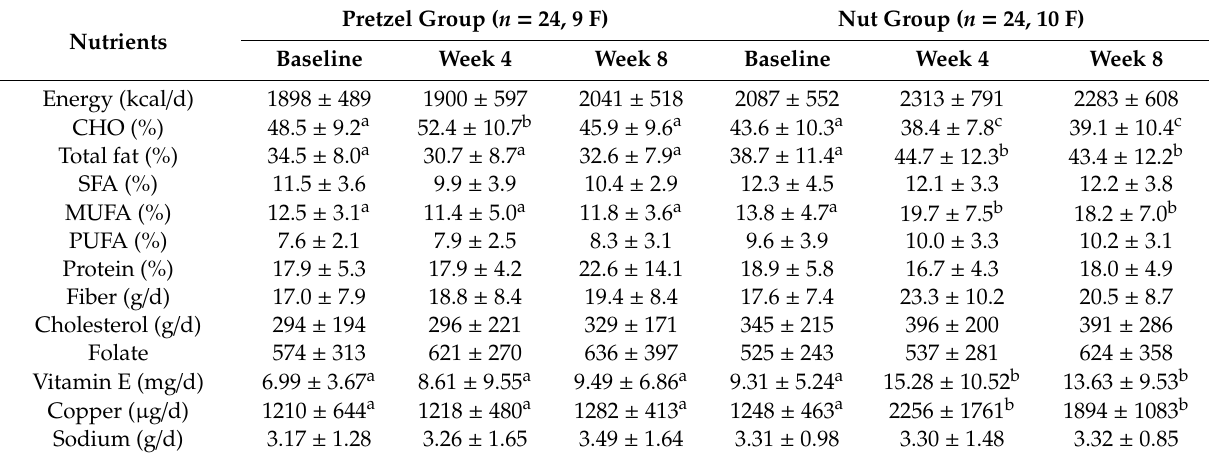
Table 2. Energy and nutrient intakes at baseline, week 4, and week 8 in the pretzel and the nut groups.